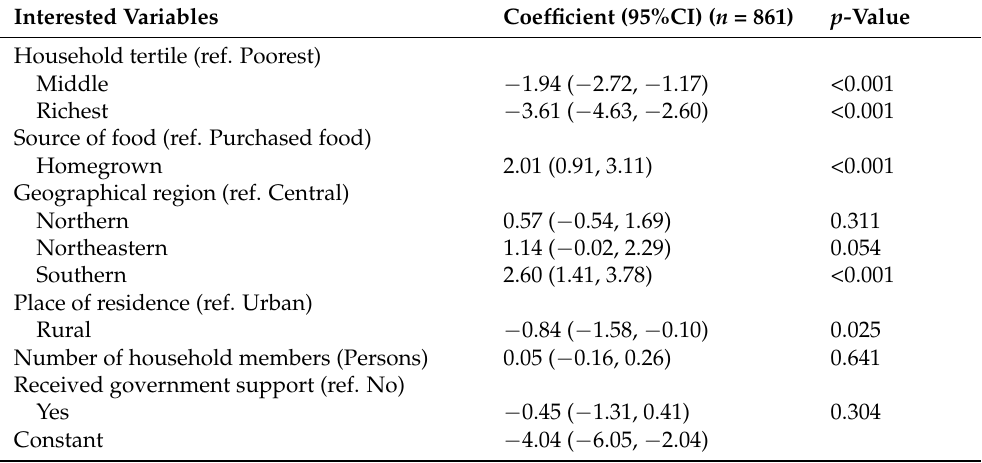
Table 4. Association between socio-economic status and food insecurity score using Tobit